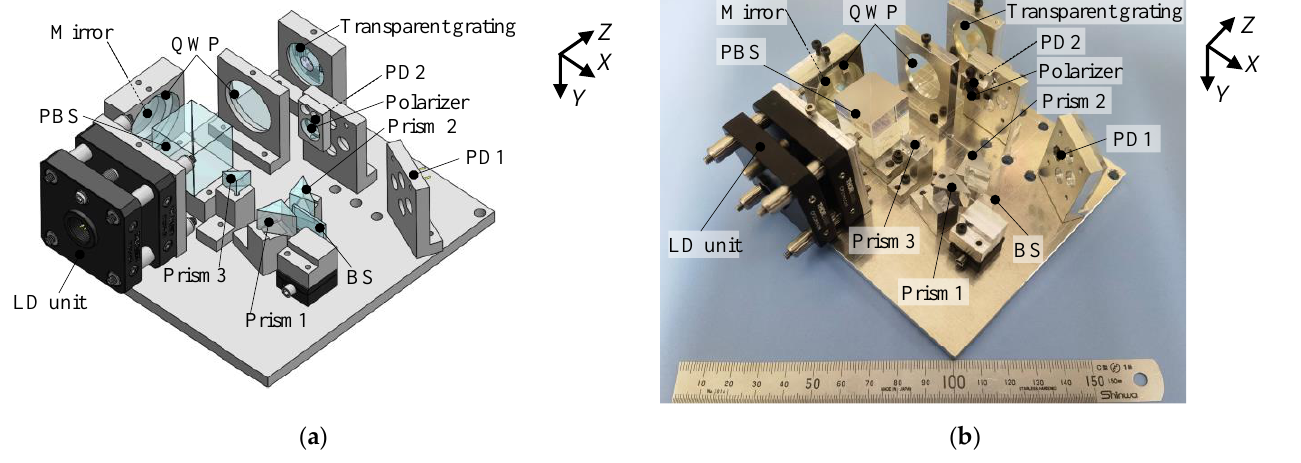
Figure 4. Prototype sensor head: ( a ) A three-dimensional model; ( b ) A photograph.